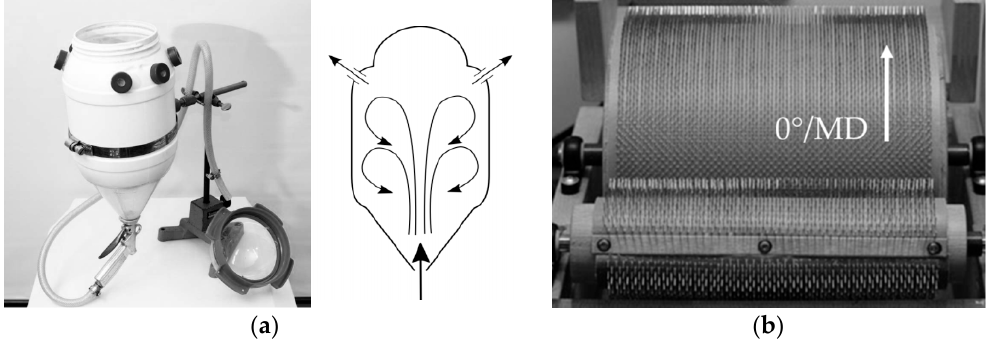
Figure 4. Reinforcement manufacturing process with fibre opening and mixing in a capsule with turbulent air ( a ) and nonwoven web formation on a small-scale electric card with two rotating drums ( b